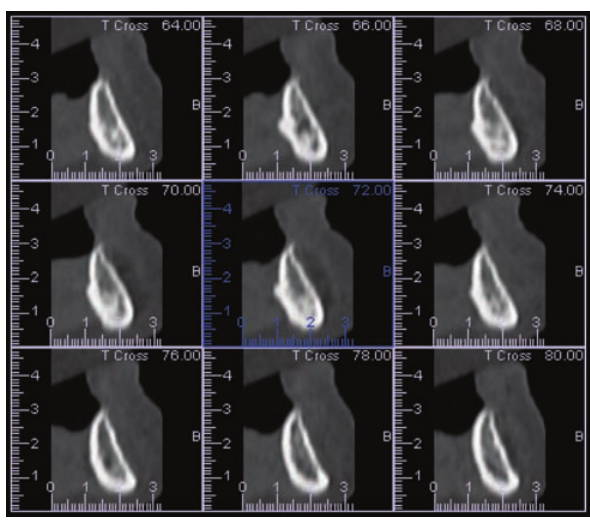
FIGURE 3 – Mandible tomographic section made in the Dental Slice software